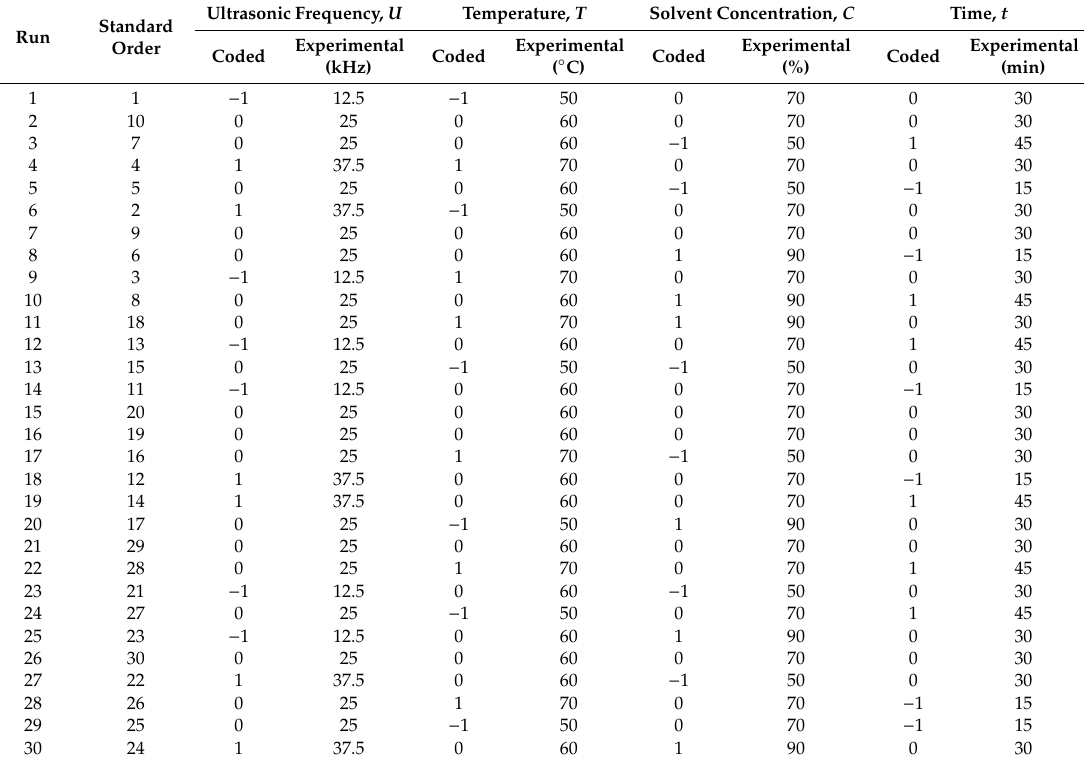
Table 4. Experimental and coded values for RSM.